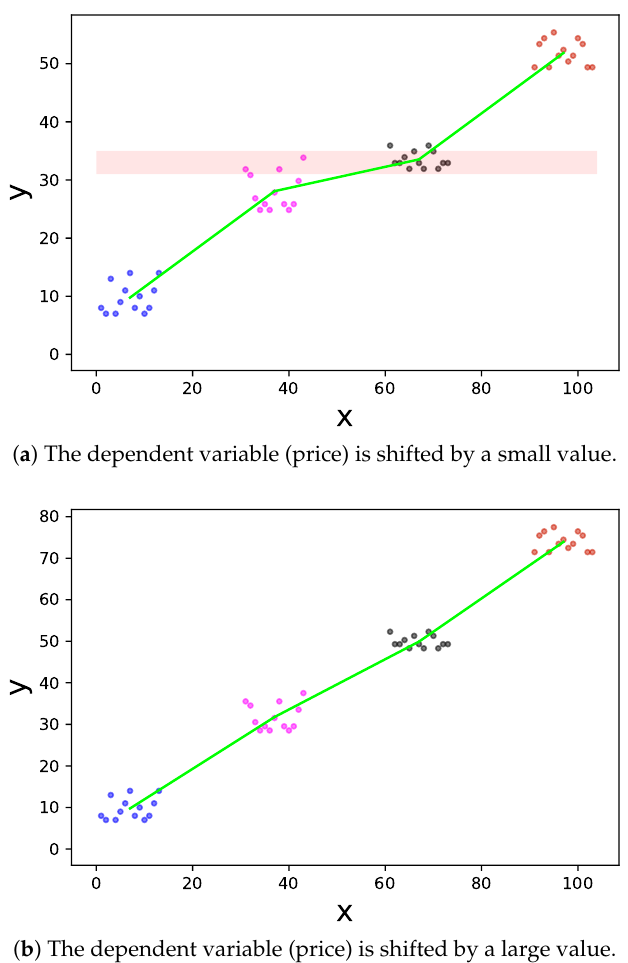
Figure 3. A motivational example of increasing the between-group variation, where the dependent variable (price) has two different shifting effect